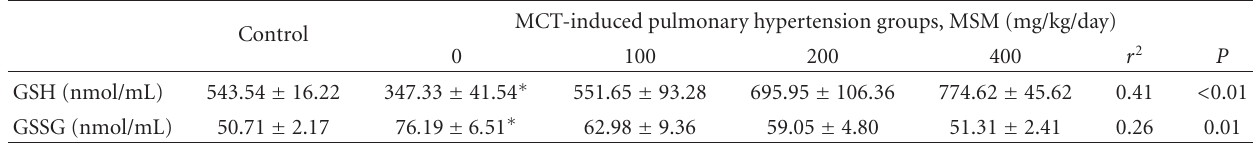
Table 3: E ff ects of di ff erent doses of methylsulfonylmethane (MSM) on the levels of reduced glutathione (GSH) and disulfide-oxidized glutathione (GSSG) and MDA in rats with monocrotaline- (MCT-) induced pulmonary hypertension.